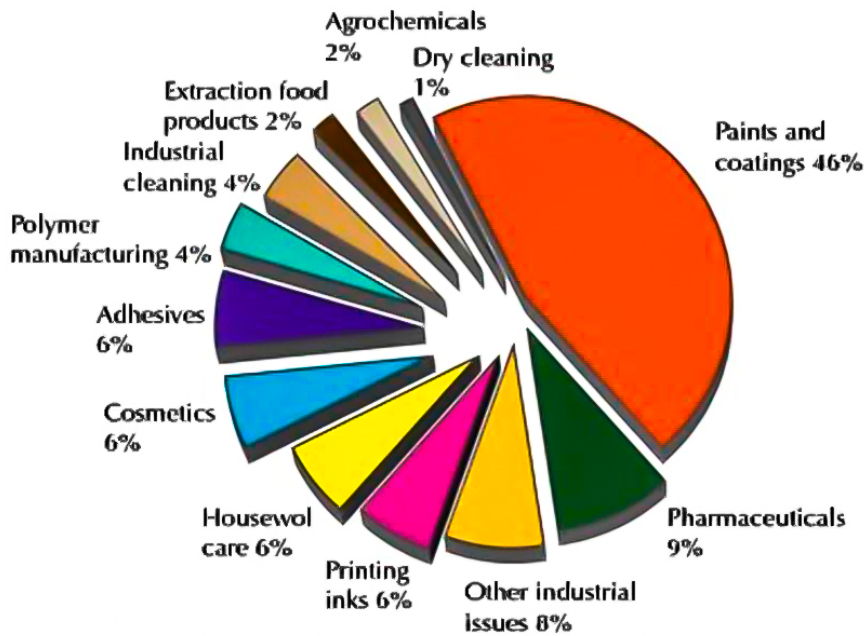
Figure 1. Average of use of solvents in different sectors. Reproduced with permission from [1].